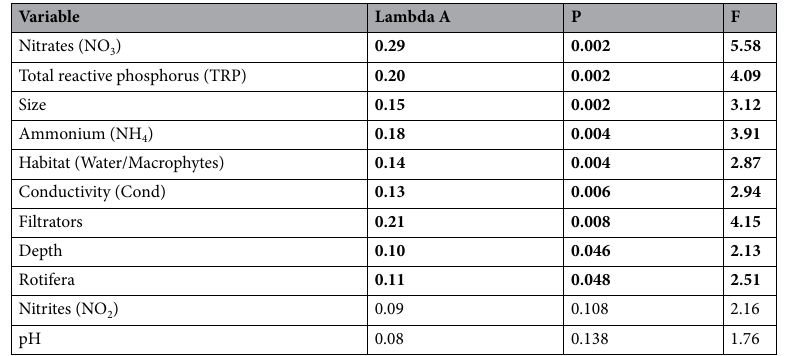
Table 4. Results of CCA on relation between abundance of chlorophyte species and diversity and physical– chemical and biological parameters among different habitats of ponds (Water vs. Macropytes). Values of p and F are calculated using Monte Carlo permutation test with 999 permutations. The overall percentage of explained variance was 25.15%. Bold = variables significantly adding to the model at p < 0.05 level (see Fig.